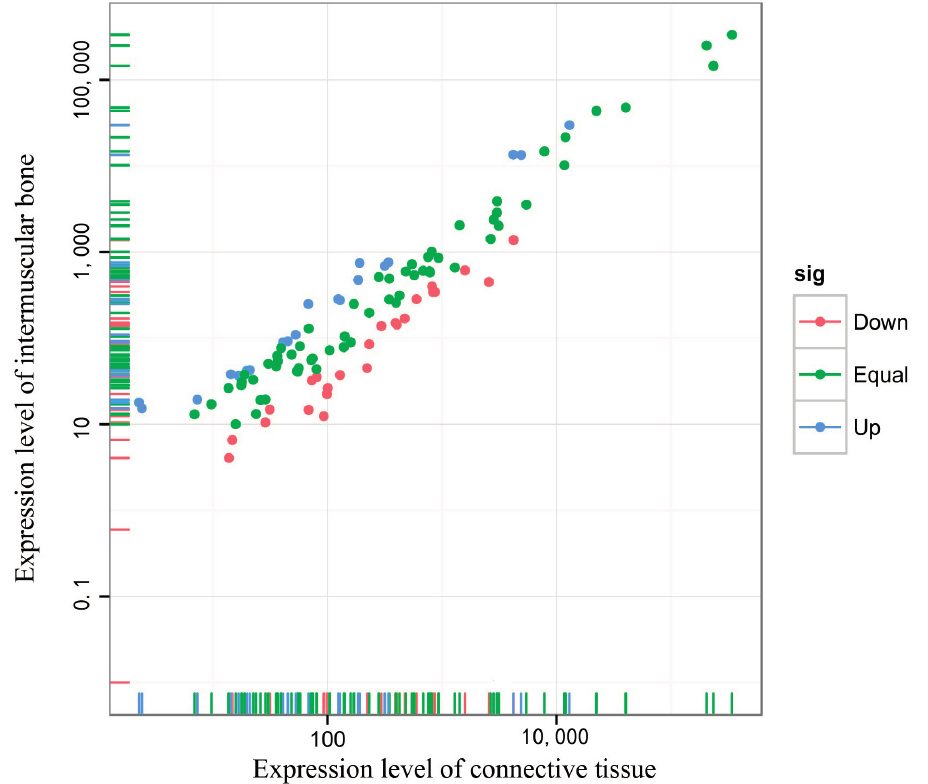
Figure 5. Scatter plot map for miRNA expression levels in the IBs and CT of M. amblycephala . Each plot represents an individual miRNA. This reflects the proportion of miRNAs that have a greater number in IBs and CT,